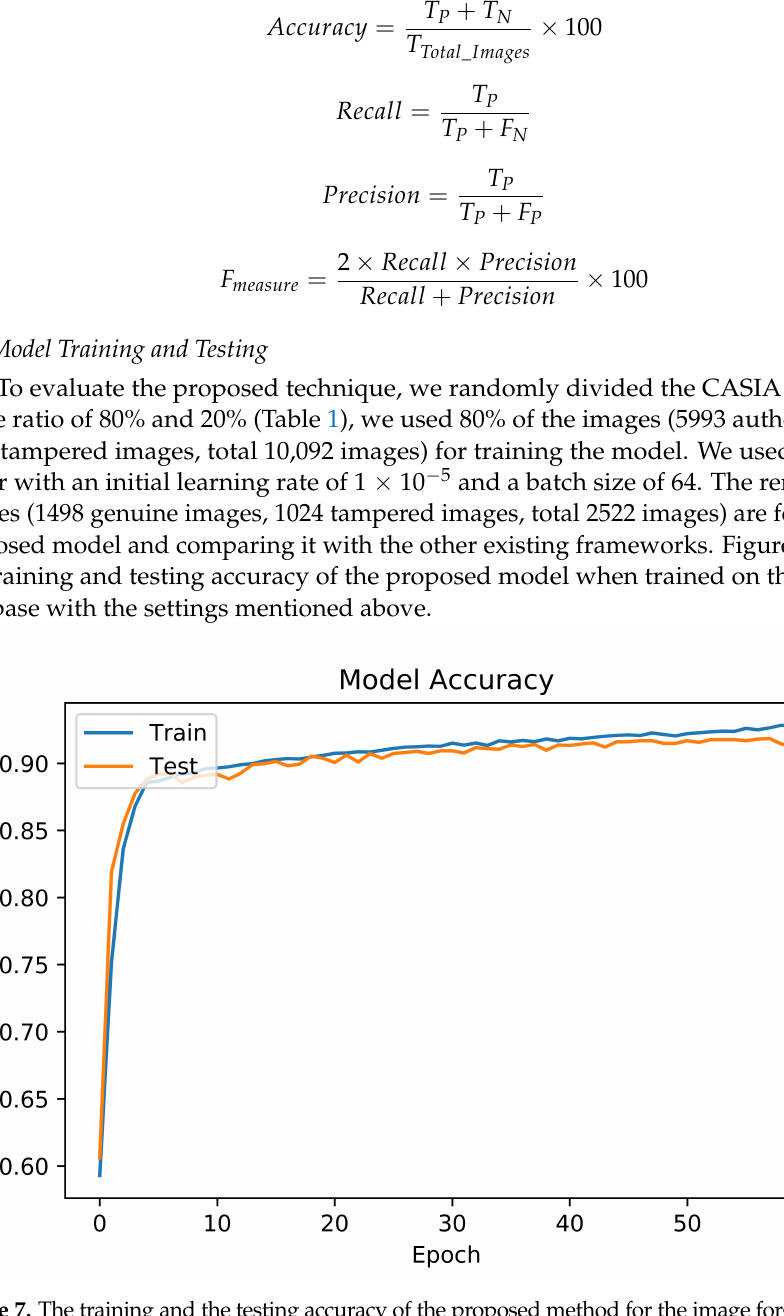
Figure 7. The training and the testing accuracy of the proposed method for the image forgery